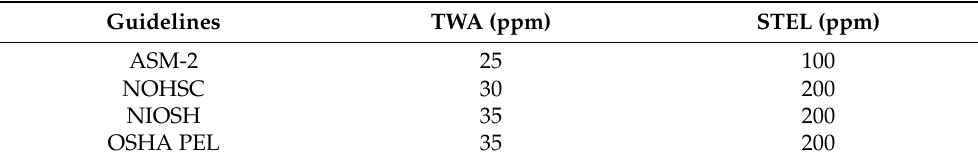
Table 2. Exposure limits for CO according to international health and safety regulations [2,8,12].